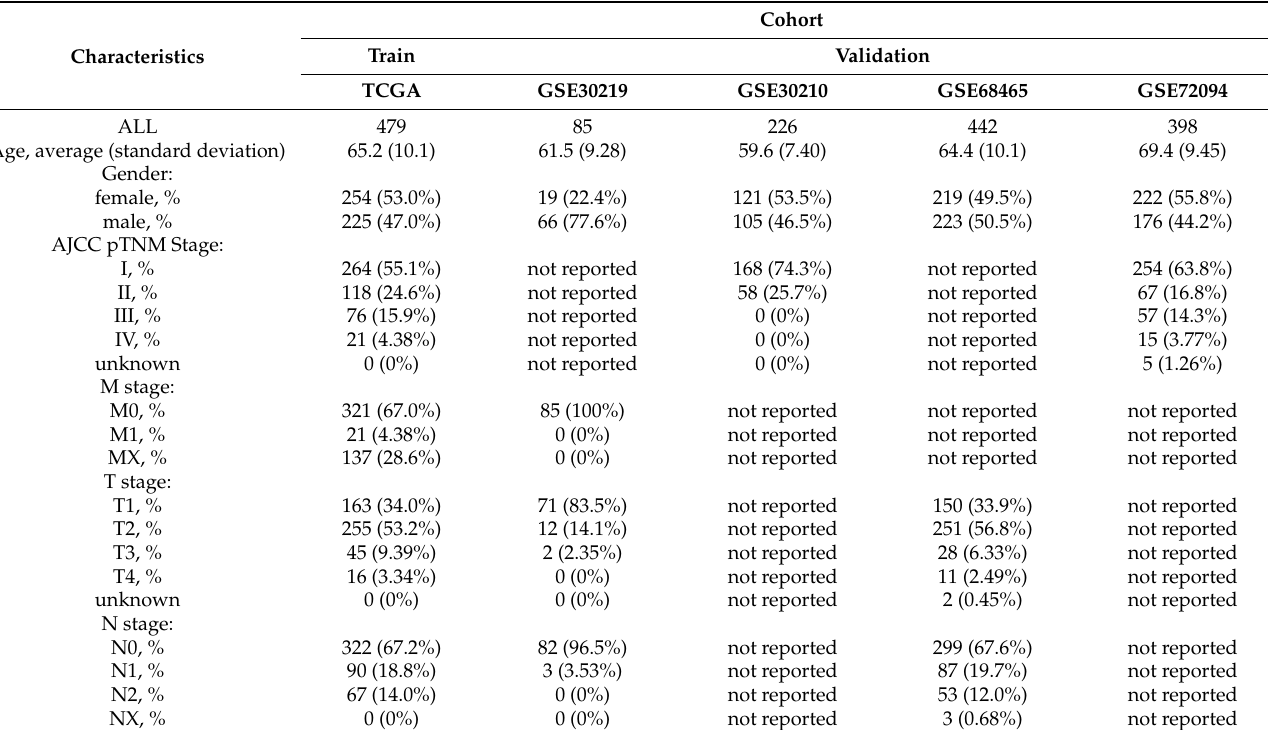
Table 1. Clinical characteristics of LUAD patients included in the construction and validation of the prognostic